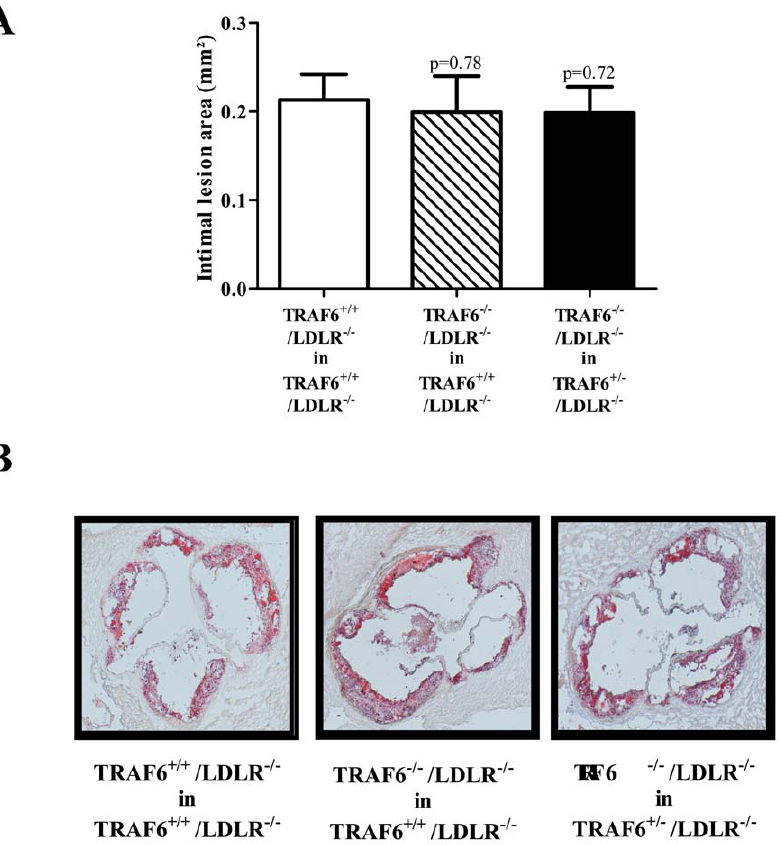
Figure 4. TRAF6 deficiency does not modulate atherogenesis in mice. Lethally irradiated 6 week old TRAF6 + / + /LDLR 2 / 2 mice received TRAF6-deficient (hatched bars, N=21) or competent fetal liver cells (white bars, N=21), TRAF6 + / 2 /LDLR 2 / 2 mice received TRAF6-deficient fetal liver cells (black bars, N=22) only. Subsequently, all groups consumed high cholesterol diet (HCD) for 18 weeks. Intimal lesion area of the atherosclerotic plaques in aortic roots was quantified. Pooled mean intimal lesion area 6 SEM are shown as graphs in the upper panel (A), representative sections stained with oil red O below (B).